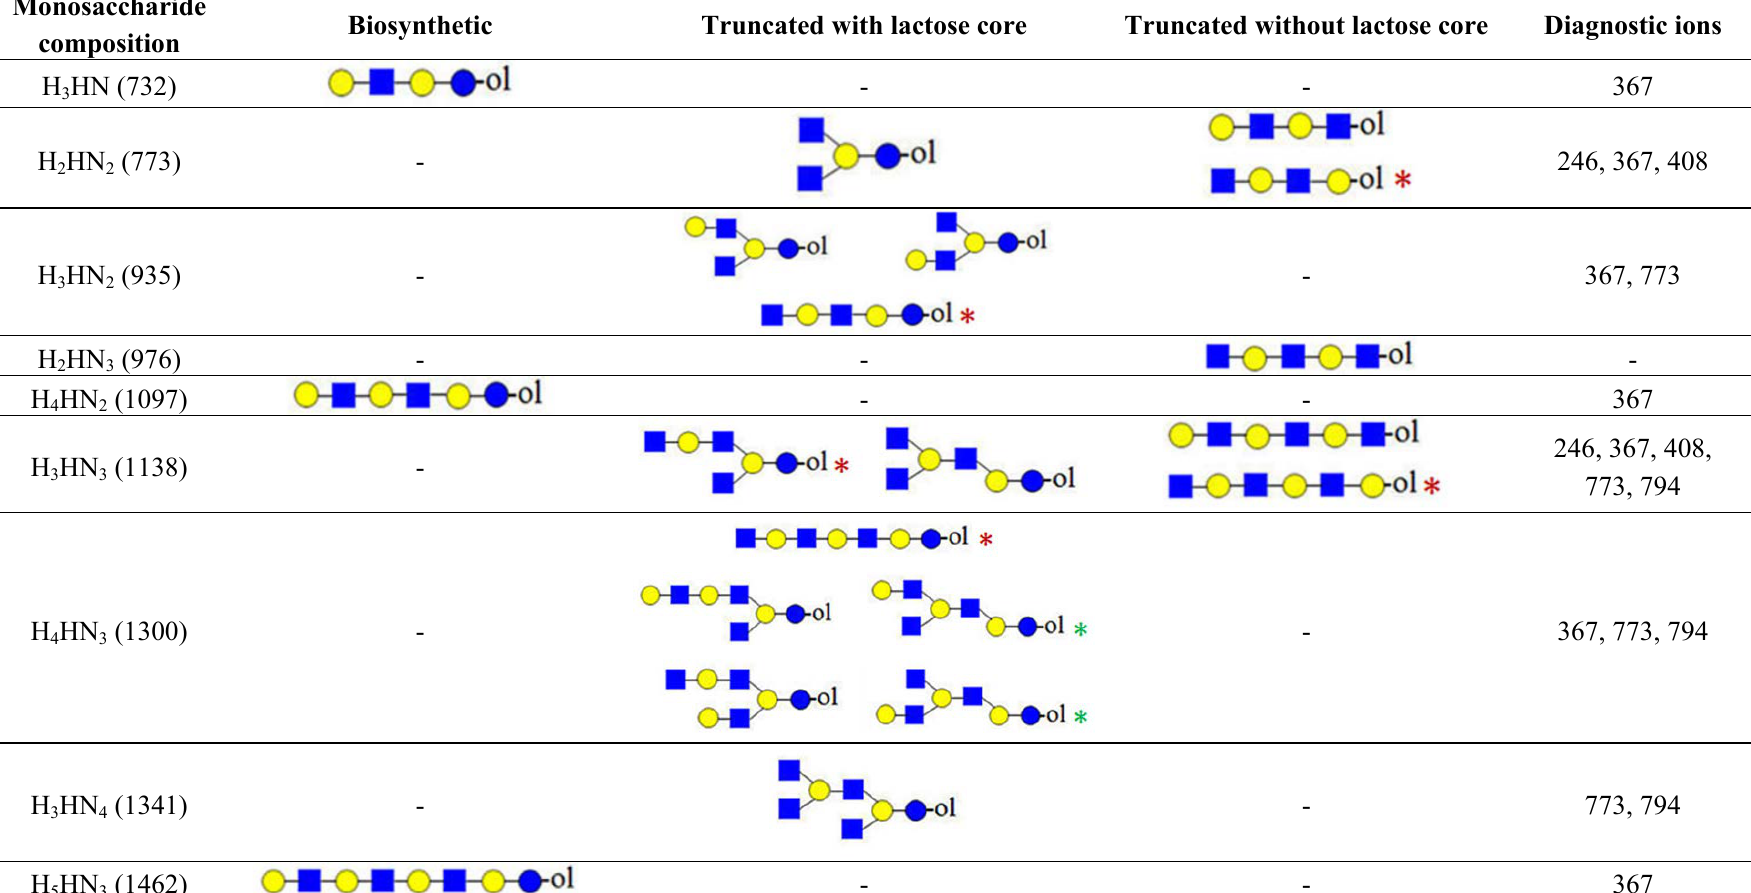
Table 2. C onfirmed and proposed oligosaccharide alditol structures along with respective diagnostic ions. Additional branched isomers are possible, due to galactose 1-3 and 1-4 linkages, and most of them are further fucosylated in vivo with fucose 1-2, 1-3 or 1-4. denotes N -acetylglucosamine, galactose, glucose and fucose. * structures that could be neither confirmed nor excluded. * present in very small